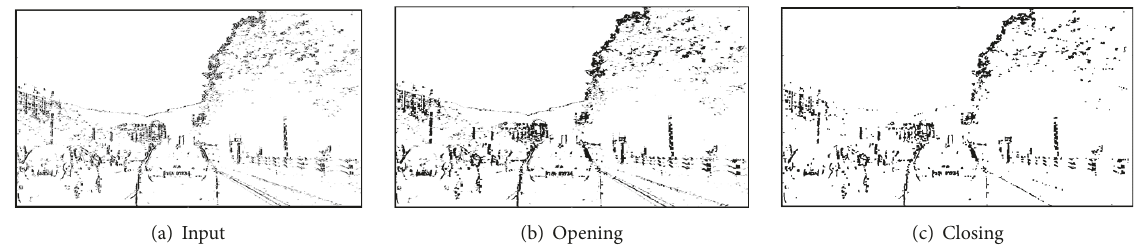
Figure 3: Morphology operations to remove noise and strengthen character areas.